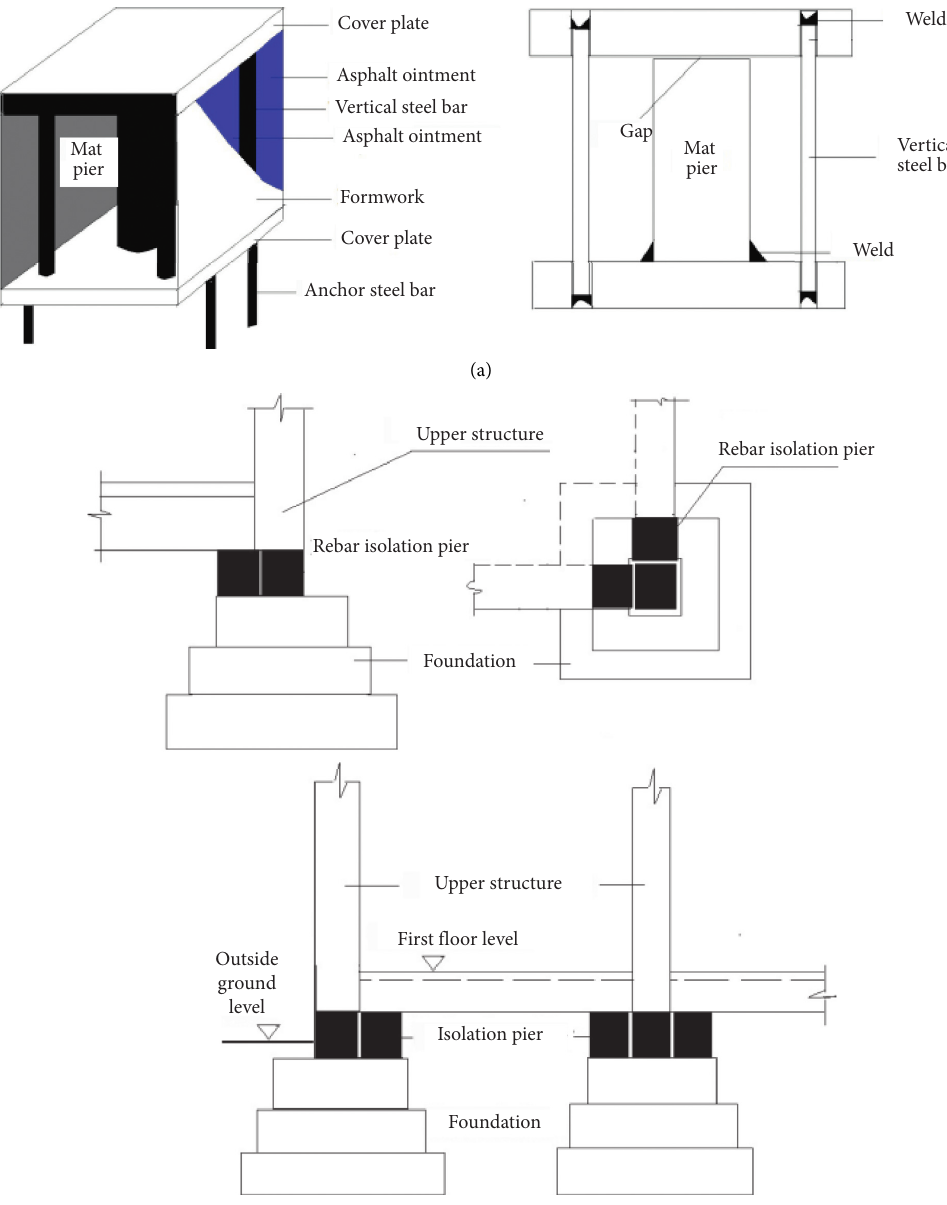
Figure 1: The structure and arrangement of the rebar isolation pier: (a) structural details of the rebar isolation pier and (b) floor plan and elevation plan of the rebar isolation